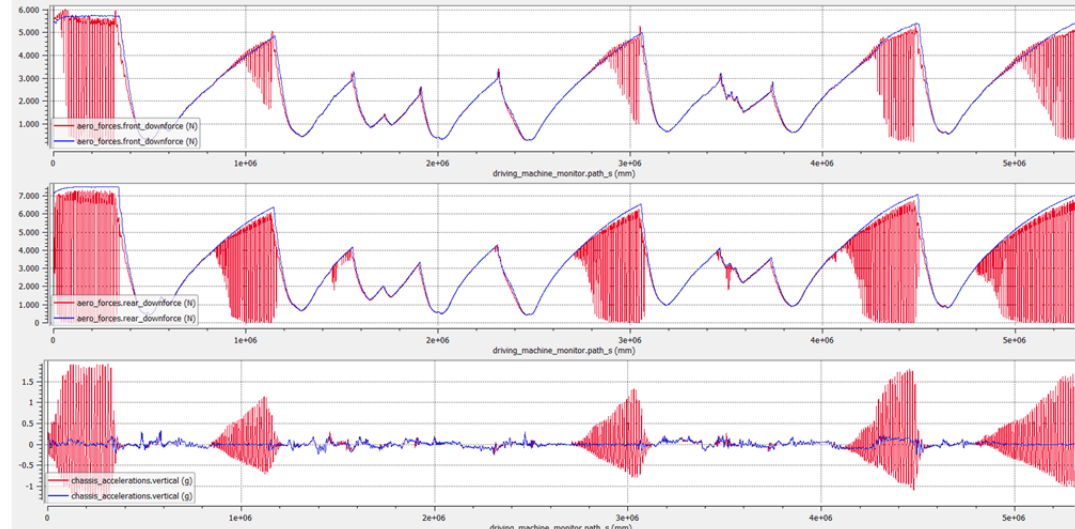
Figure 33. Baseline setup (blue, #1) vs. model with decay functions/porpoising (red, #2). Top and mid plot are the front and rear downforce vs. lap distance, bottom plot is the vertical acceleration at the center of gravity.